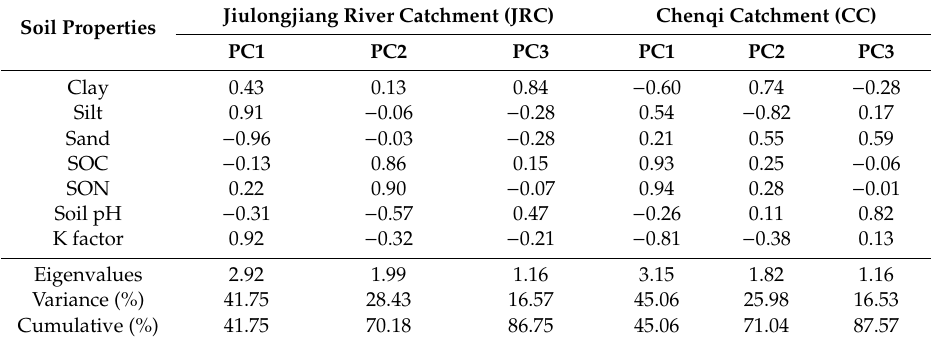
Table 3. Principal component analysis of soil properties and K factor.